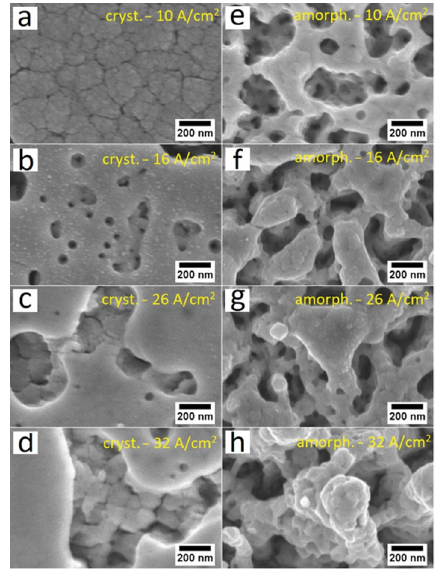
Figure 1. Surface SEM images of crystalline ( a – d ) and amorphous ( e – h ) WO 3 thin films after ion beam irradiation with current densities: ( a,e ) 10 A/cm 2 , ( b,f ) 16 A/cm 2 , ( c,g ) 26 A/cm 2 , ( d,h ) 32 A/cm 2 .